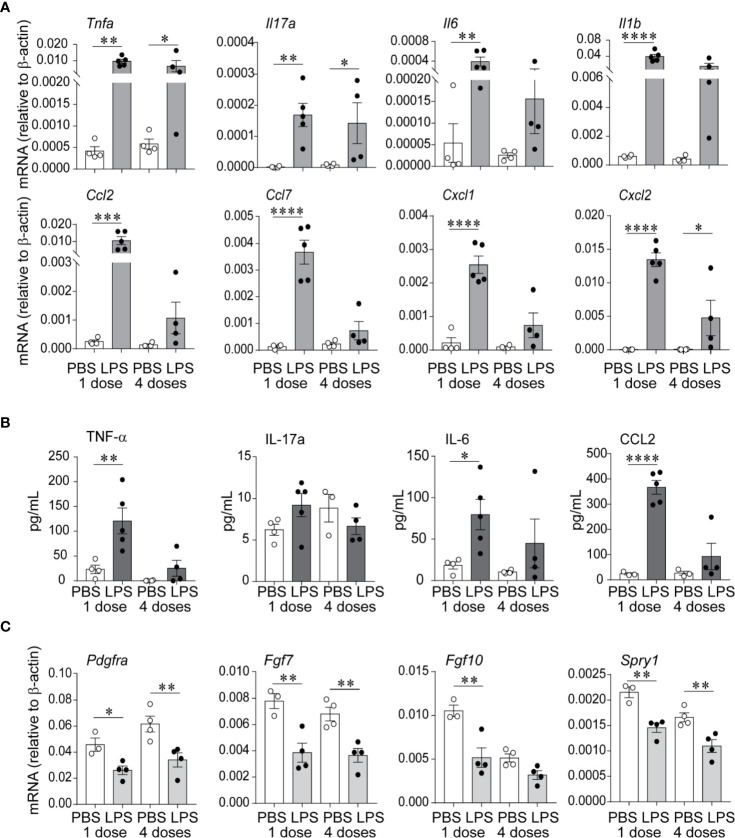
Repetitive airway LPS exposure induces lung pro-inflammatory cytokine and chemokine expression and downregulates the expression of genes required for lung alveolar and mesenchymal cell development. Immature mice were inoculated with LPS or PBS intranasally on days of life 3, 5, 7, and 10. Whole lung mRNA and protein were measured by quantitative PCR and ELISA after the first and after the last (fourth) LPS inocculation. (A) LPS increased whole lung mRNA expression of Tnfa, Il17a, Il6, Il1b, Ccl2, Ccl7, Cxcl1, and Cxcl2. (B) Effects of LPS on whole lung protein expression of TNF-α, IL-17a, IL-6, and CCL2. (C) LPS decreased whole lung mRNA expression of Pdgfra, Fgf7, Fgf10, and Spry1. (n = 4–5 per group, mean ± SEM, *P < 0.05, **P < 0.01, ***P < 0.001, ****P < 0.0001, one-way ANOVA). The experiment was repeated three times with similar results.